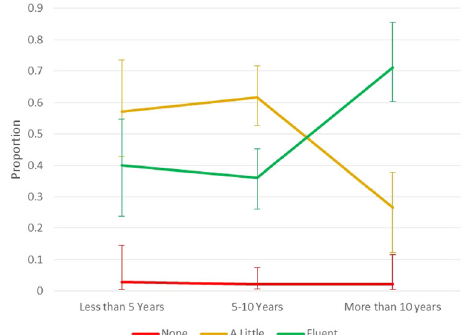
Fig. 5 Spoken Malay language skills for respondents who arrived aged 19 or older, by time in Malaysia. Vertical bars represent 95% con fi dence intervals on population